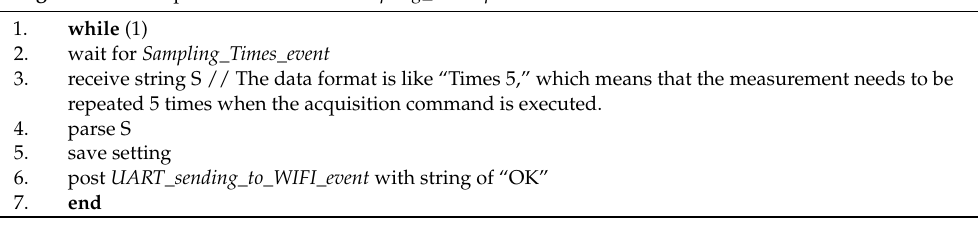
Algorithm 4: The pseudo code of the Sampling_Times